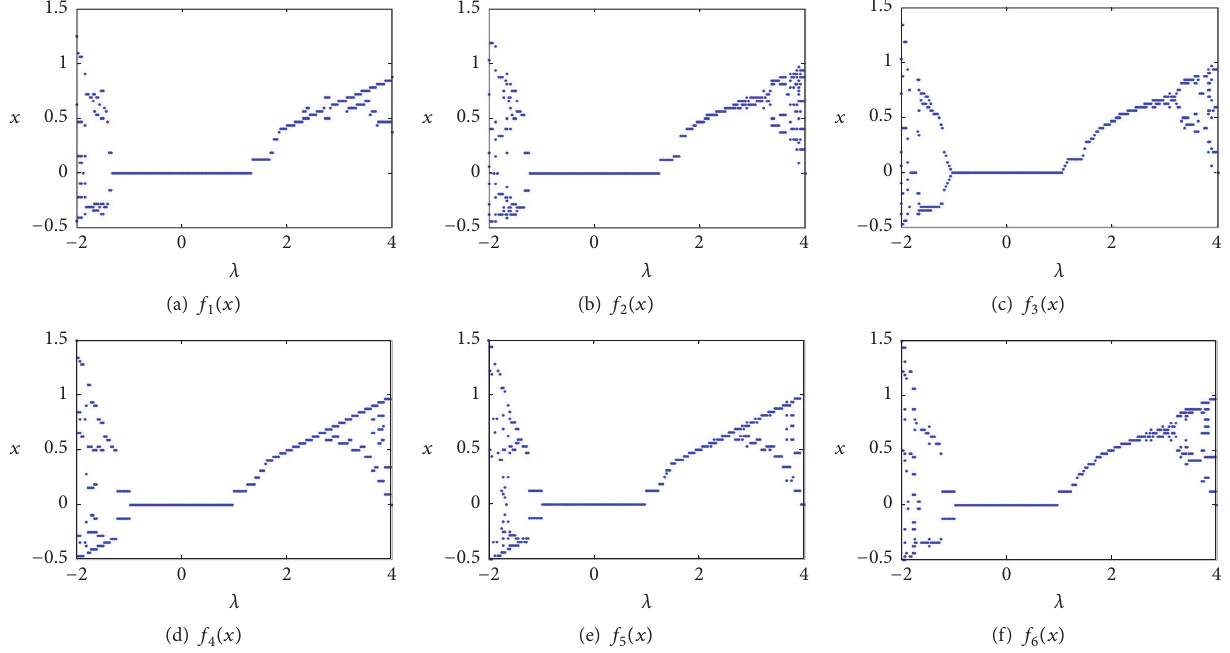
Figure 4: Bifurcation diagram versus the control parameter 𝜆 for six different orders starting at 𝑥 0 = 0.125 at 𝑝 = 9 ( 𝑝 𝑓 = 5 bits).